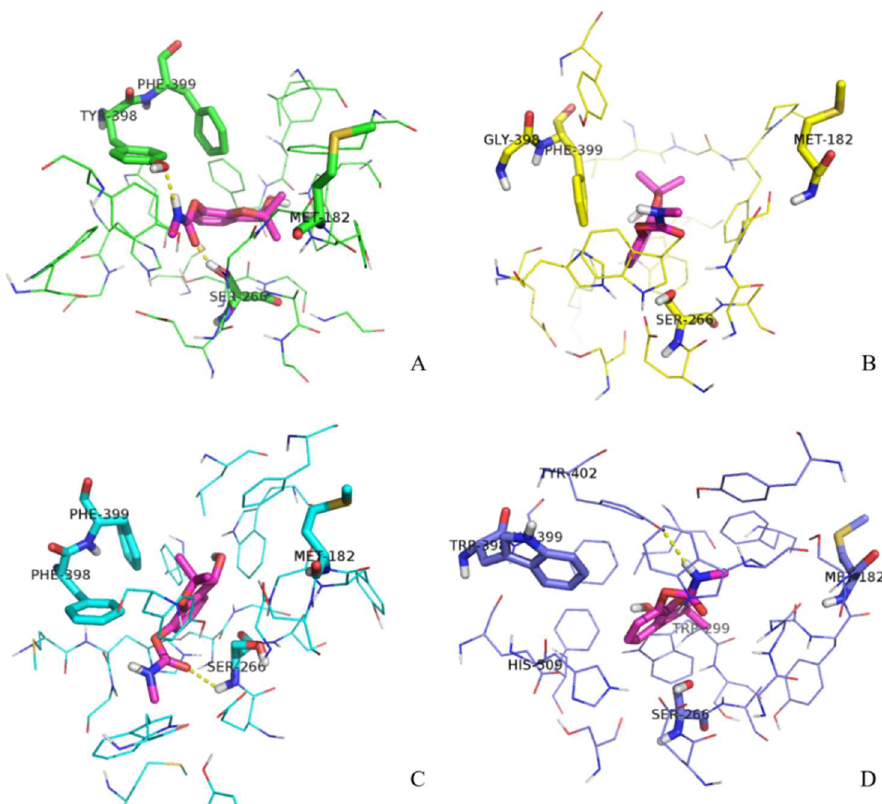
Figure 9. Conformations of Carbofuran-3-hydroxy after pulling for 1 ns at 400 KJ · mol − 1 · nm − 1 . Substrate Carbofuran-3-hydroxy is in pink stick representation. The structure of the gorge residues and catalytic S266 of wild type enzyme Y398 ( A ), Y398G mutant ( B ), Y398F mutant, ( C ) and Y398W mutant ( D ) of r Bm AChE II are shown.